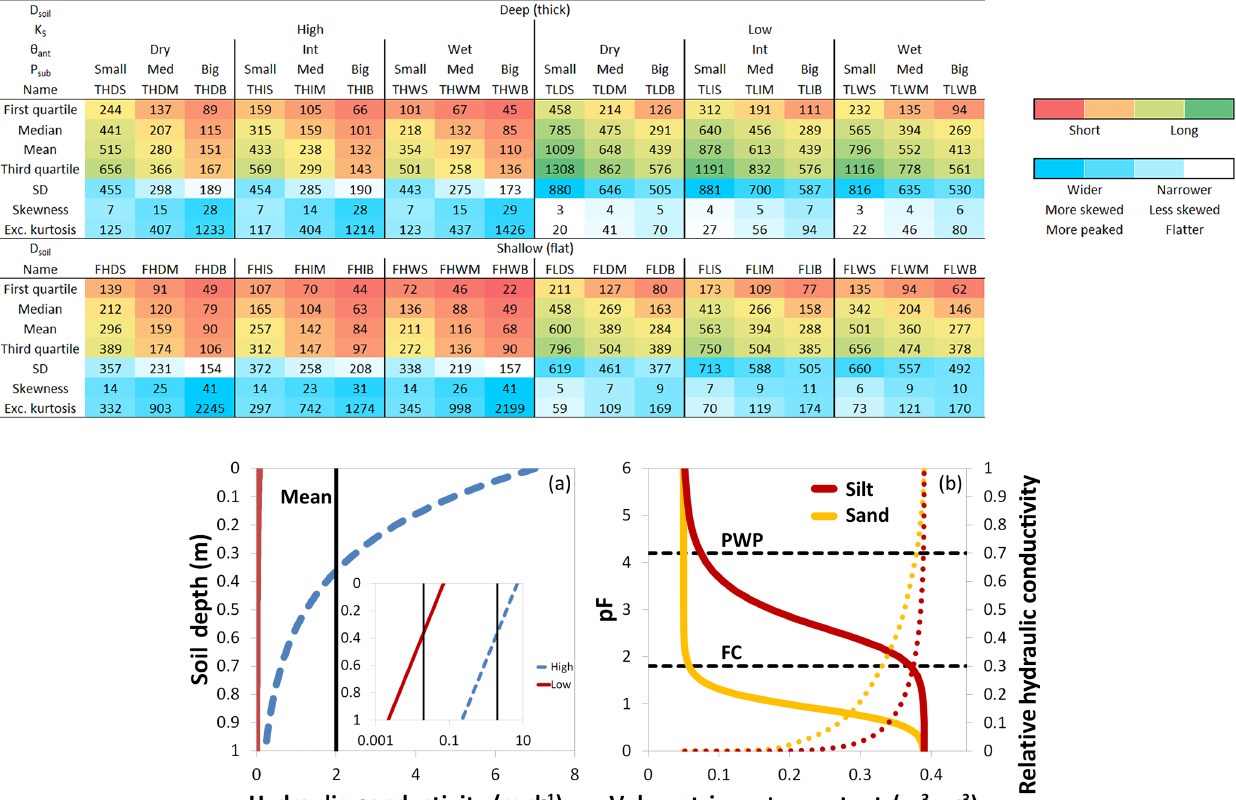
Table 1. Metrics of the TTDs derived from the modeling of 36 scenarios with different combinations of catchment and climate properties. All times are given in days.